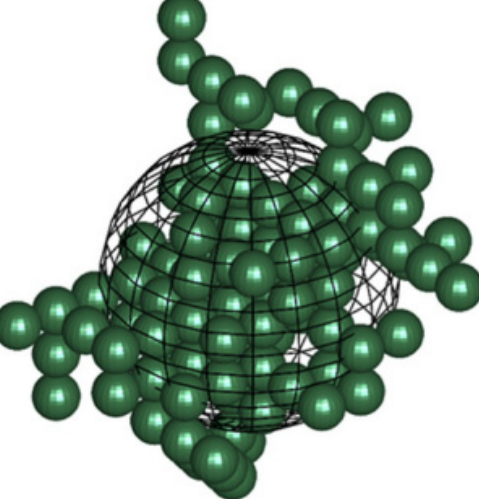
Figure 1. Illustration of the radius of gyration 𝑅 (cid:3034) of an aggregate.